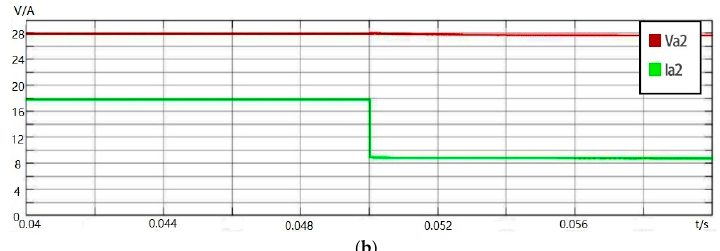
Figure 12. Output waveform. ( a ) output voltage, current waveform and local magnification diagram under optimal control mode; ( b ) Output waveform in the case of load transient variation.